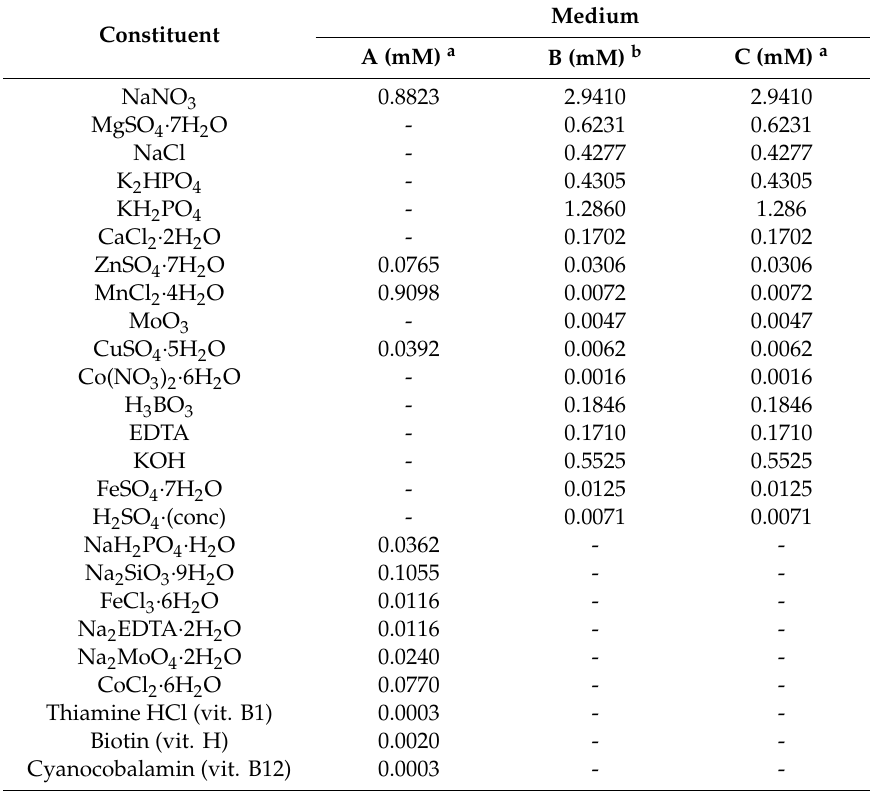
Table 2. Nutrient composition of di ff erent culture media. F / 2 medium ( A ), Bold’s Basal medium ( B ), alternative medium ( C